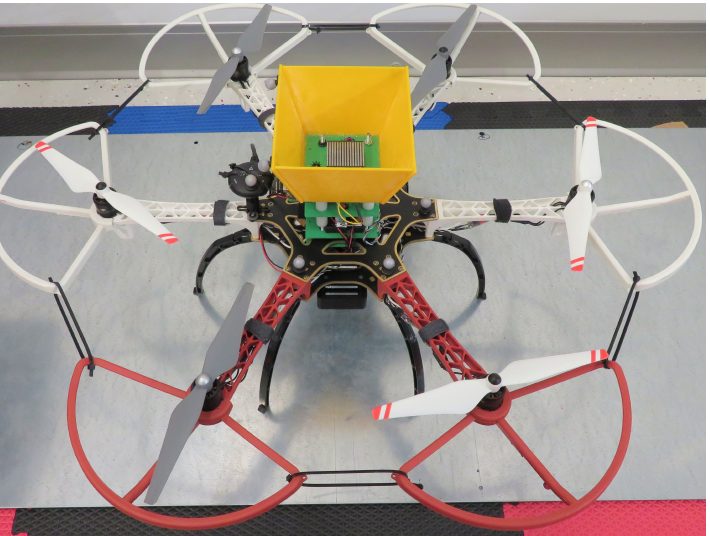
Figure 5. Overview of the custom Unmanned Aircraft System (UAS or drone) developed for sensor deployment and